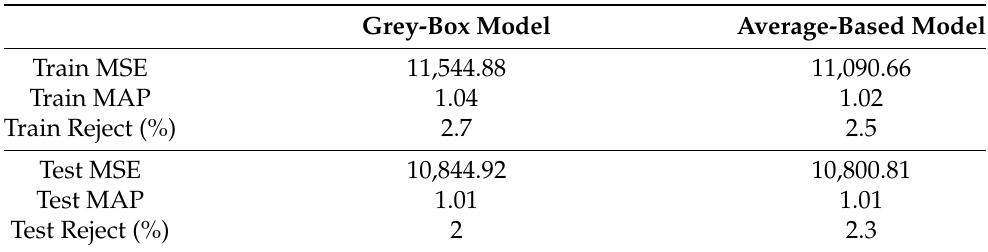
Table 2. Prediction errors in mean squared error (MSE), mean average percentage error (MAP) and percentage of rejected welds for the first version of our model versus the reference average-based